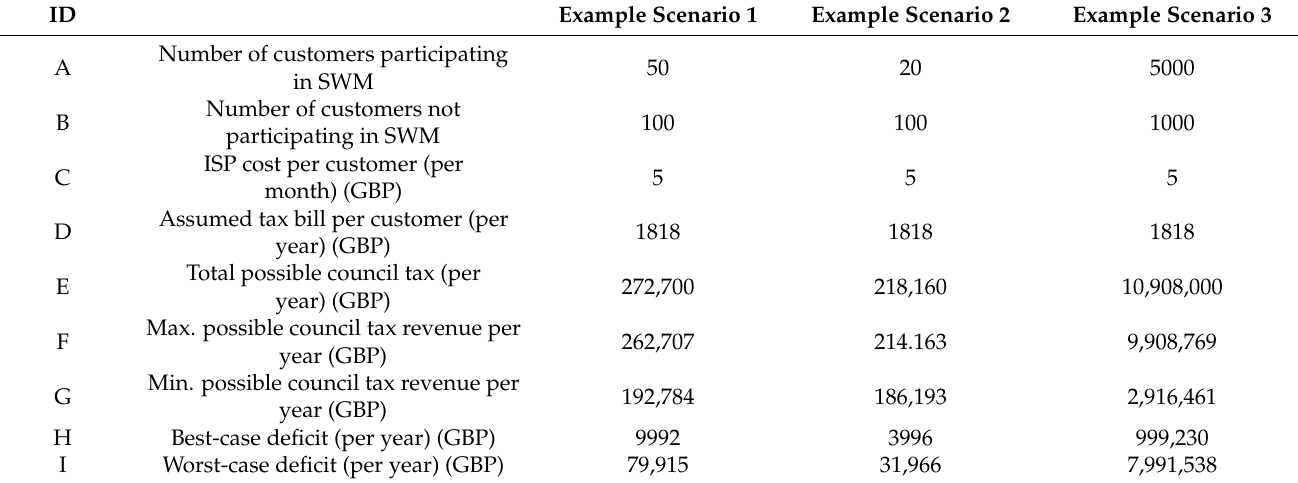
Table 10. Example scenarios capturing financial cost–benefits of